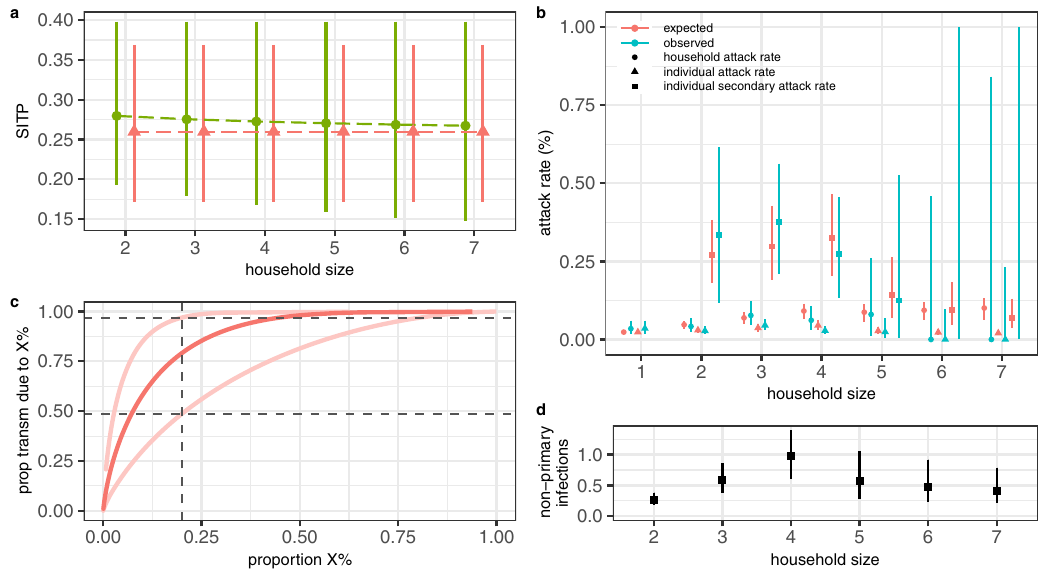
Fig. 5 Within-household SARS-CoV-2 transmission estimates. a Mean (points) and 95% CrI (lines) of the Susceptible-Infectious Transmission Probability (SITP) estimates by household size obtained with model V (red) and PV (green). b Mean (points) and 95% CI (lines) of the observed household, individual-level and secondary attack rates compared to the mean and 95% CrI of the estimated attack rates obtained with model V. c Median (dark) and 95% CrI (light) proportion of transmission (y-axis) attributable to the most infectious proportion of infections (x-axis) obtained with model V; homogeneity in transmission would result in y = x. d Mean (points) and 95% CrI (lines) of the estimated number of non-primary infections by household size obtained with model V. In all panels, the results were obtained by sampling n = 1,000 realisations from the posterior distribution of the model